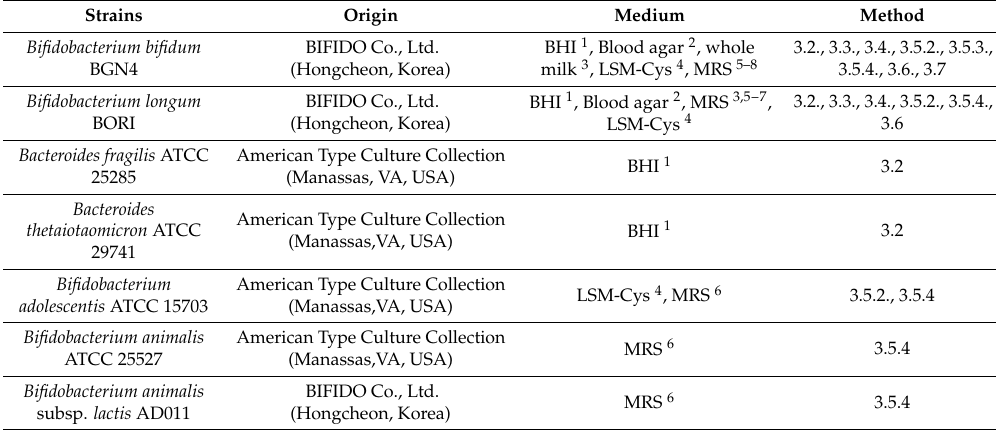
Table 6. Strain list and